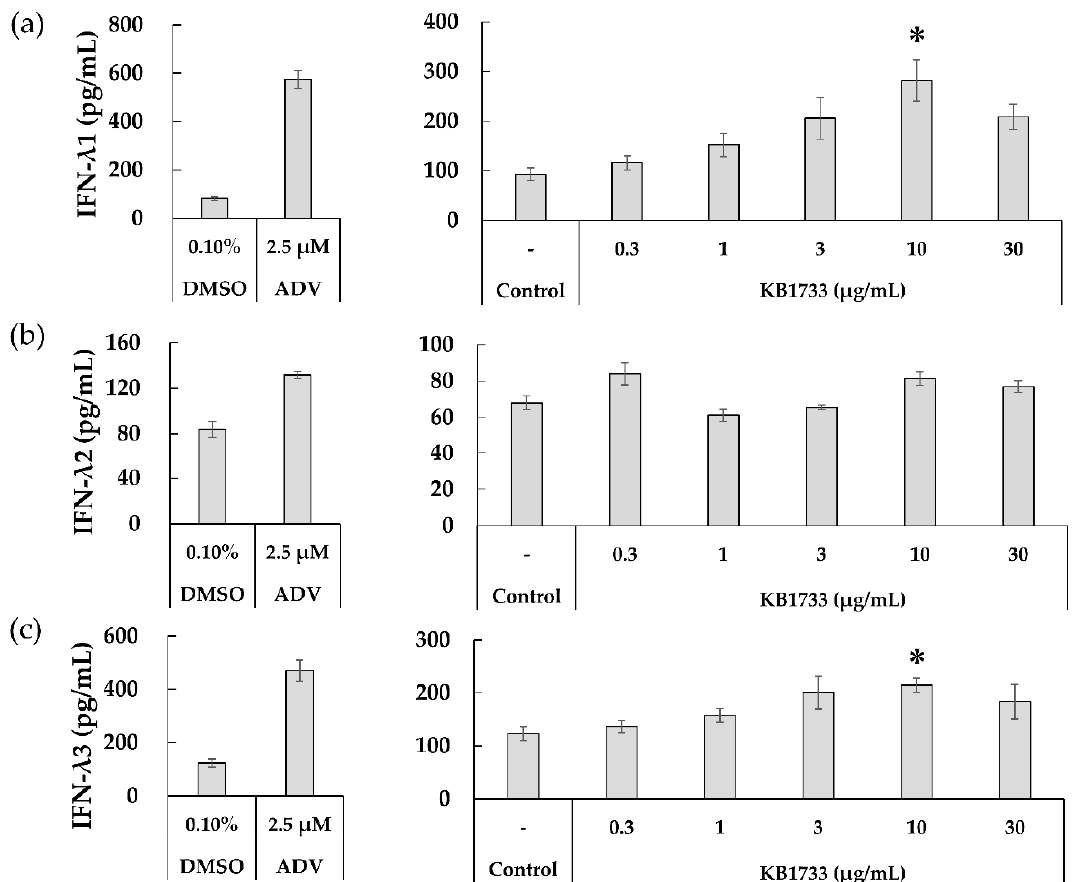
Figure 3. Production of ( a ) IFN- λ 1, ( b ) IFN- λ 2, and ( c ) IFN- λ 3 after 48 h of KB1733 treatment. DMSO: Dimethyl sulfoxide employed as a negative control, ADV: Adefovir dipivoxil employed as a positive control. The values are shown as mean ± SE. Asterisks represent a significant difference when compared to control (DMEM) ( p -value ˂ 0.05). Data from six independent experiments are shown.